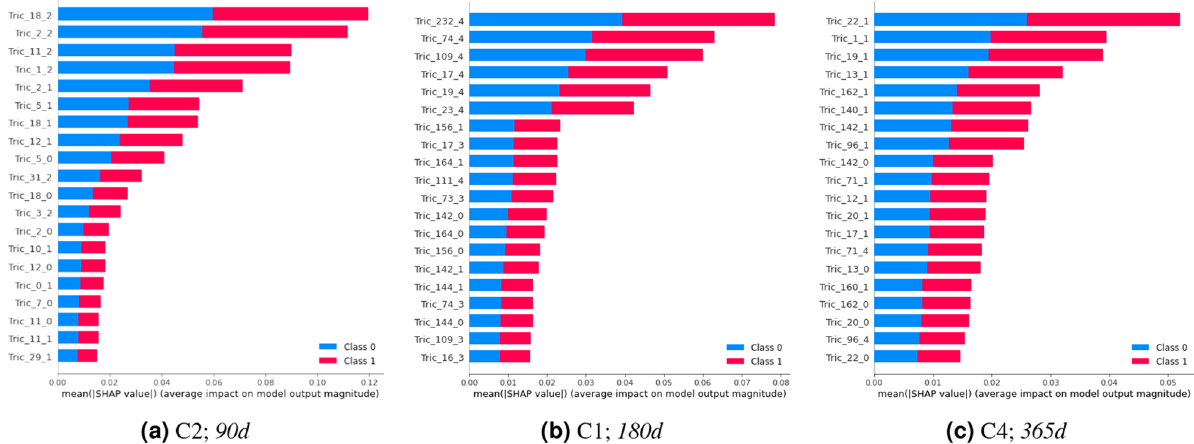
Figure 10. Top 20 patterns (triclusters) used by the triclustering-based classifiers. The terminology used is the following: patterns name starts with ‘Tric’ followed by an identifier, and the snapshot (bicluster) position in the set of snapshots, in which 0 is the first position. Class 0 represents ‘non-evolutions’, and Class 1 represents